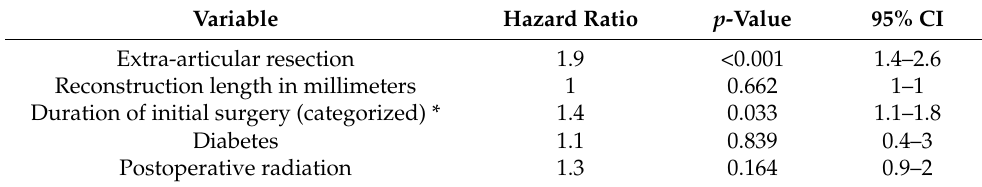
Table 4. Multivariate Cox regression analysis of risk factors for first prosthetic failure. * for the multivariate analysis the threshold value determined using Youden’s index was used as opposed to the metric value of the duration of